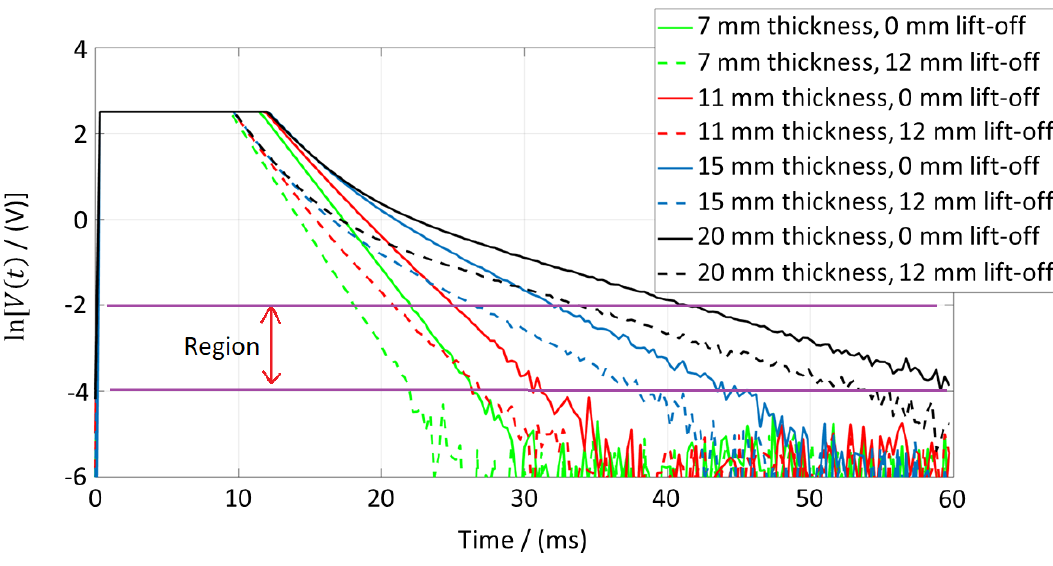
Figure 7. Manually picked linear region for straight-line fitting.